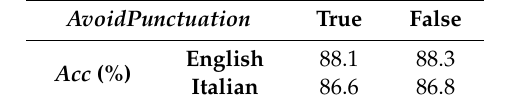
Table 5. Testing accuracy obtained by eliminating or not punctuation from text 1 .